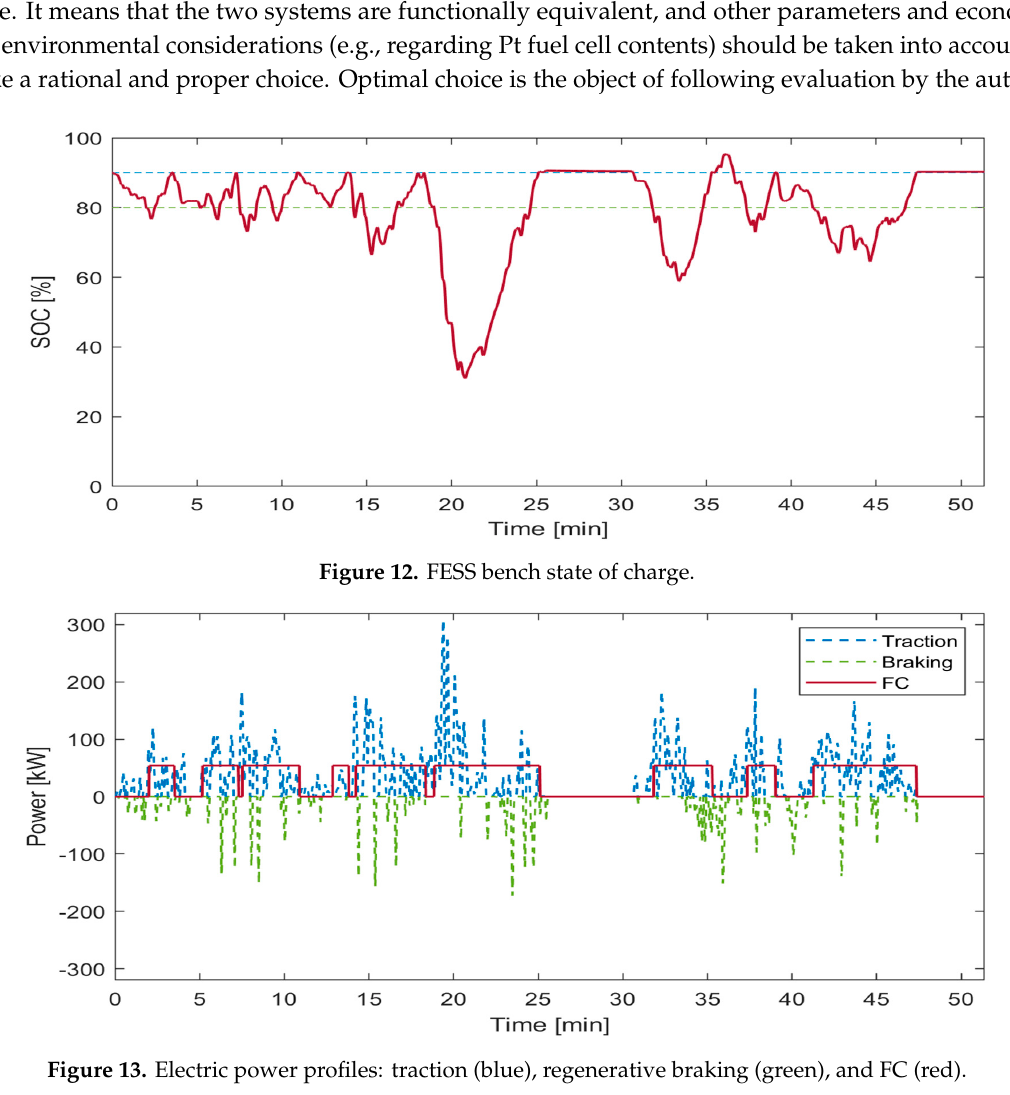
Figure 14. Power profile of the FESS bench.